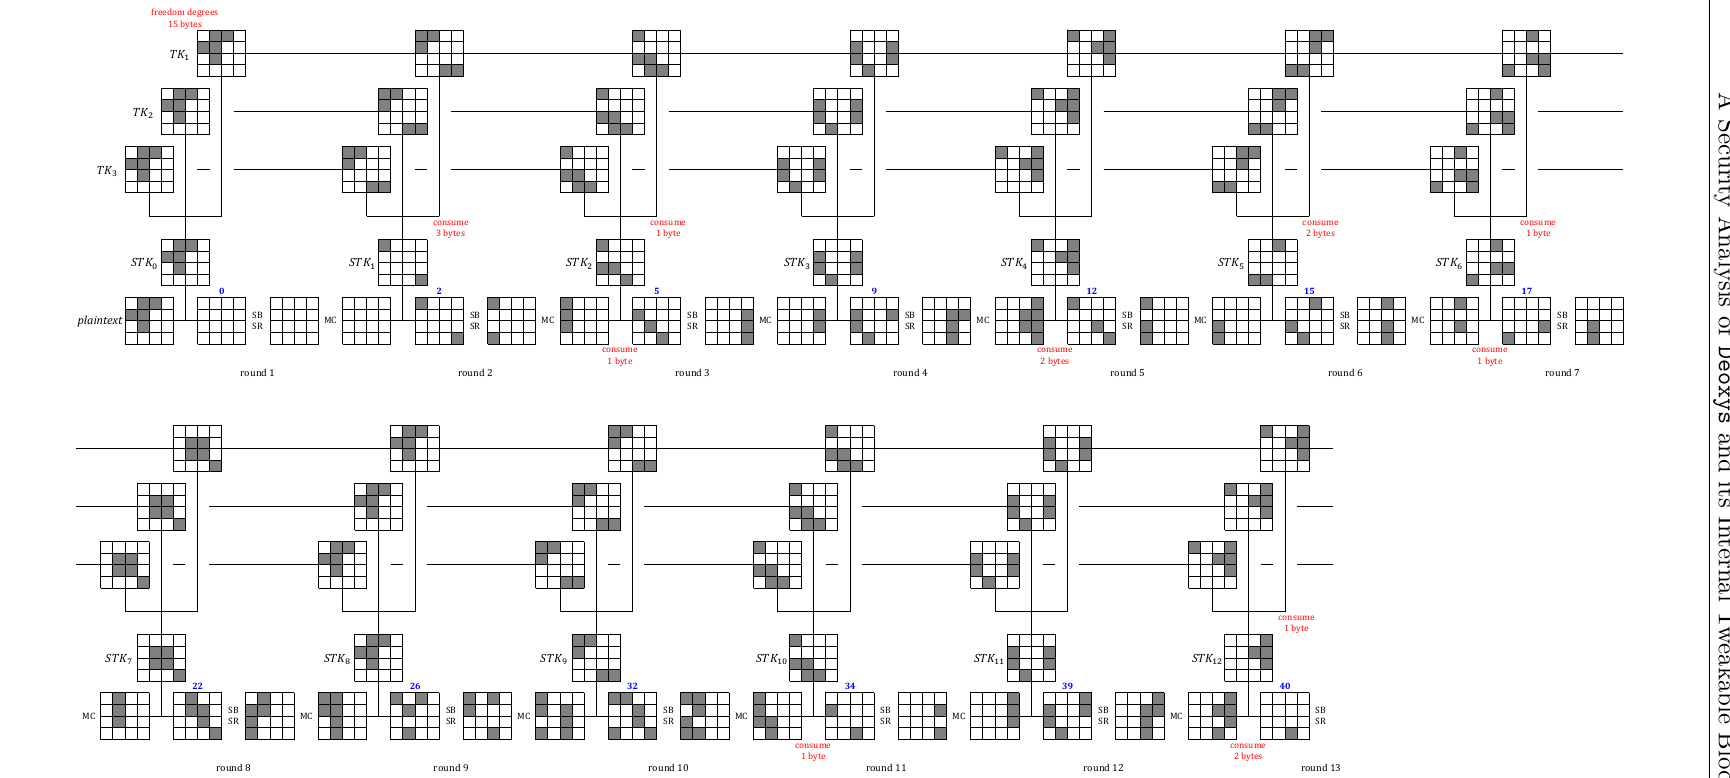
Figure 5: A 13-round truncated differential path considering degrees. Red comments explain the evaluation of degrees and blue numbers count the active